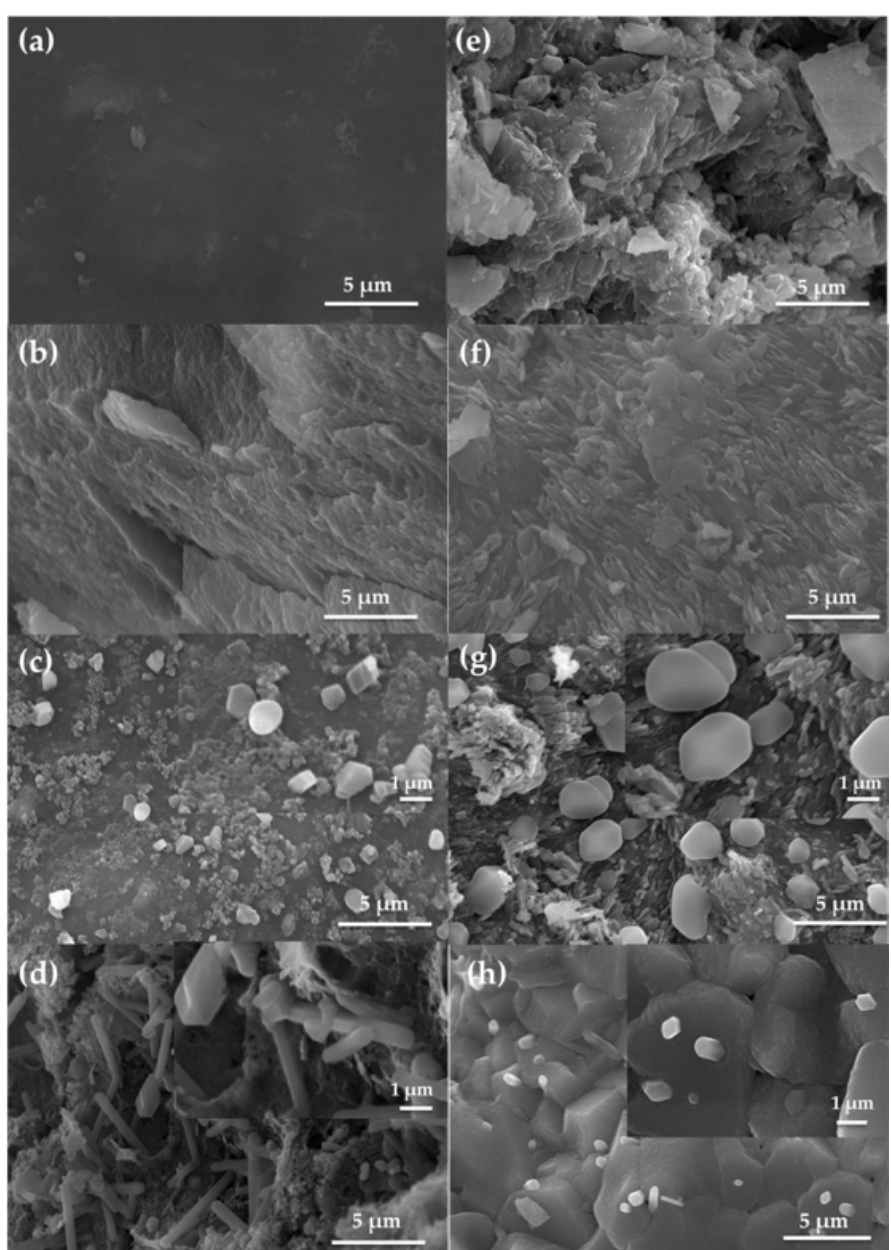
Figure 3. Scanning electron microscope (SEM) images of ( a ) CaAlg, ( b ) CaAlg at 250 °C, ( c ) CaAlg at 500 °C, ( d ) CaAlg at 900 °C; ( e ) CaAlg/rGO, ( f ) CaAlg/rGO at 250 °C, ( g ) CaAlg/rGO at 500 °C, and ( h ) CaAlg/rGO at 900 °C.